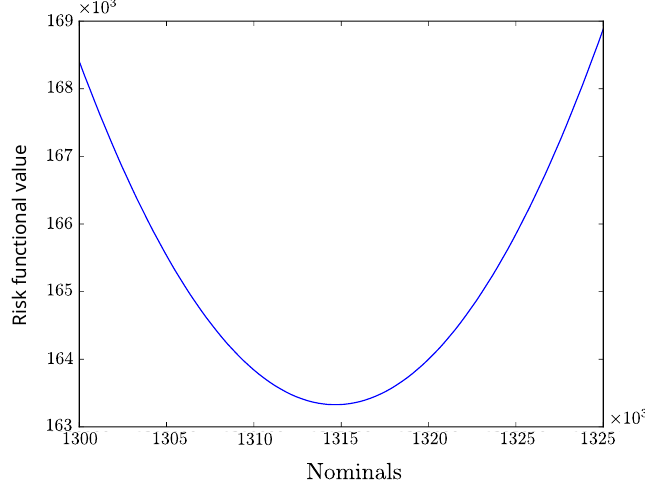
Figure 1. Graph of the one dimensional risk functional in Example 1.